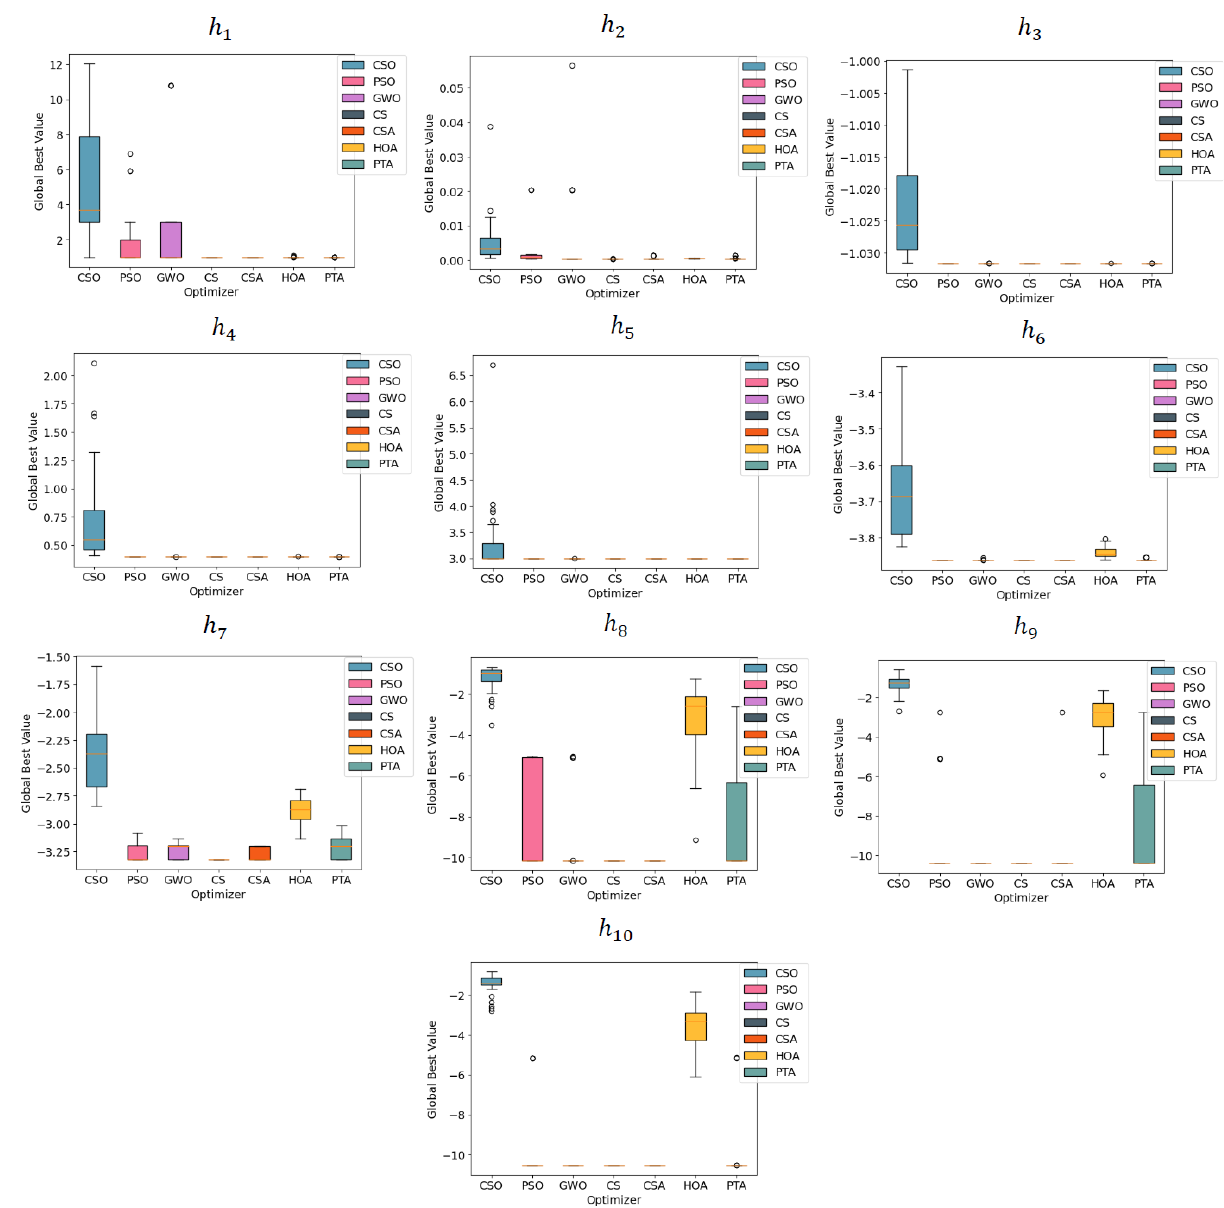
Figure 5. Boxplot Charts for the Objective Functions ℎ 1 − ℎ 10 .